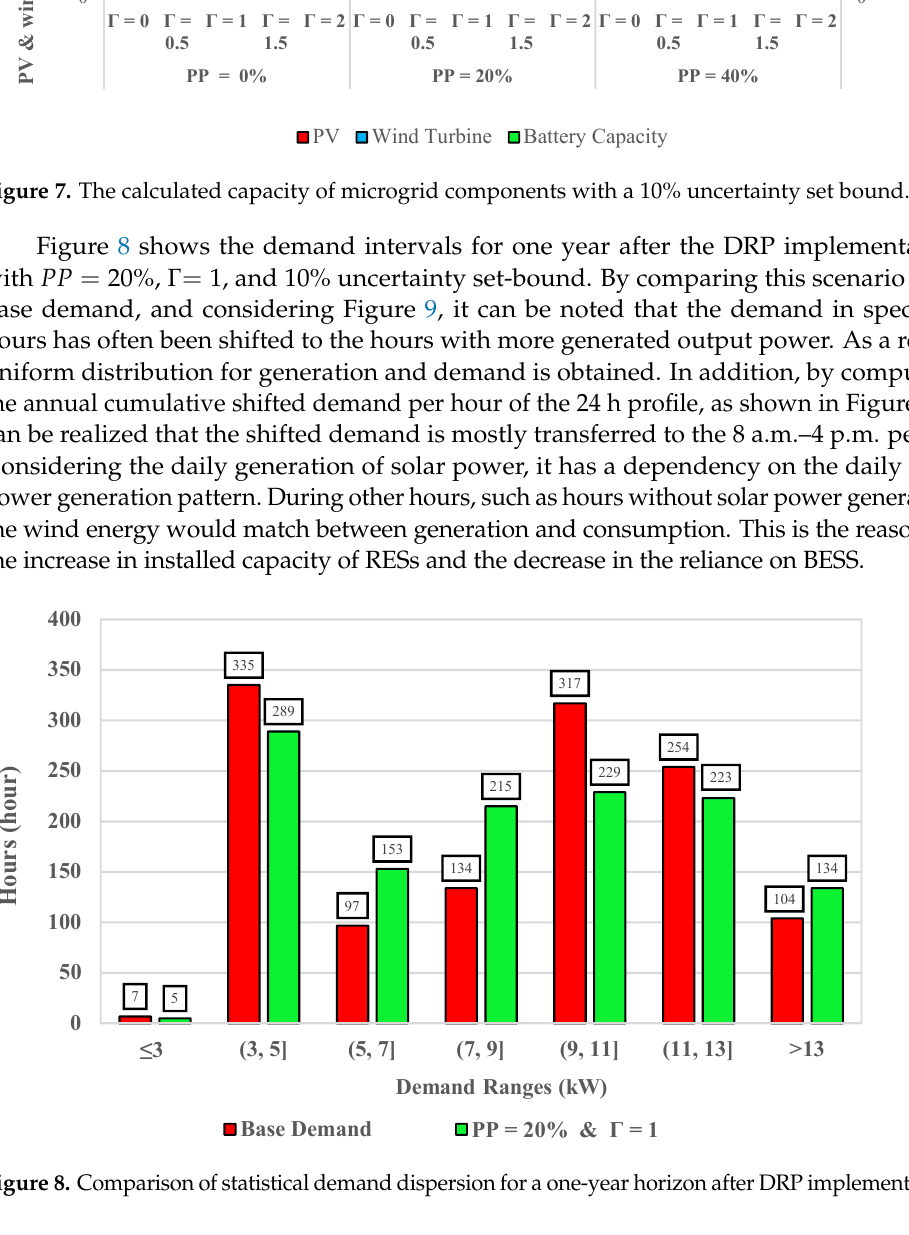
Figure 9. Total shifted cumulative demand versus average power output of a PV module for a one-year horizon. Finally, considering Figure 10, which is the comparative figure for BESS state of charge and wind speed, it is obvious that BESS state of charge is highly dependent on wind speed. It can be said that almost whenever wind speed is under the cut-in wind turbine speed, the MGCC begins to send signals to BESS.